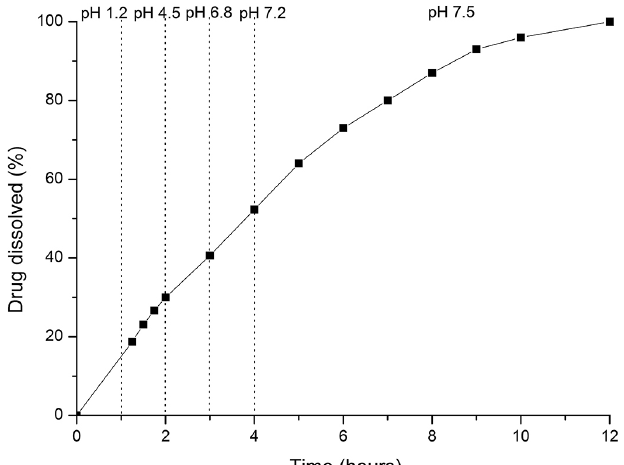
FIGURE 6 - Hypothetical dissolution profile of a gastro-resistant formulation using USP apparatus 3 in three different media (pH 1.2, 4.5 and 6.8).